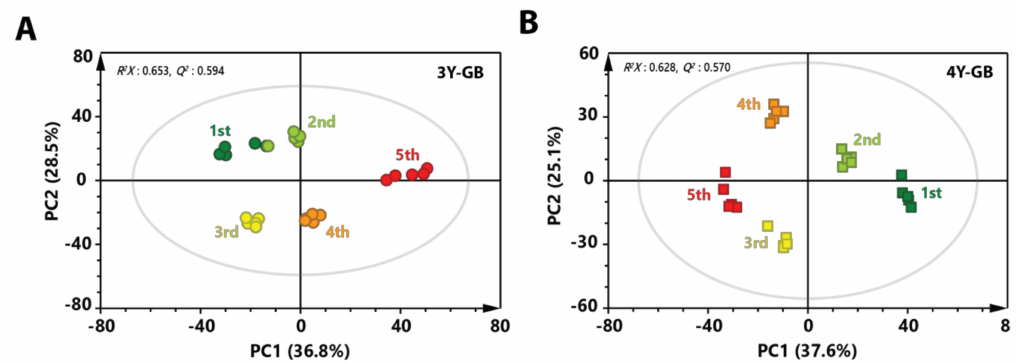
Figure 2. PCA score plot derived from GC-MS data of ( A ) three-year-old GB and ( B ) four-year-old GB with di ff erent ripening stages. Circular symbols and rectangular symbols represent three-year-old GB and four-year-old GB, respectively. The color of each symbol is as follows: green color, first harvested sample; light green, second-harvested sample; yellow color, third-harvested sample; orange color, fourth-harvested sample; red color, fifth-harvested